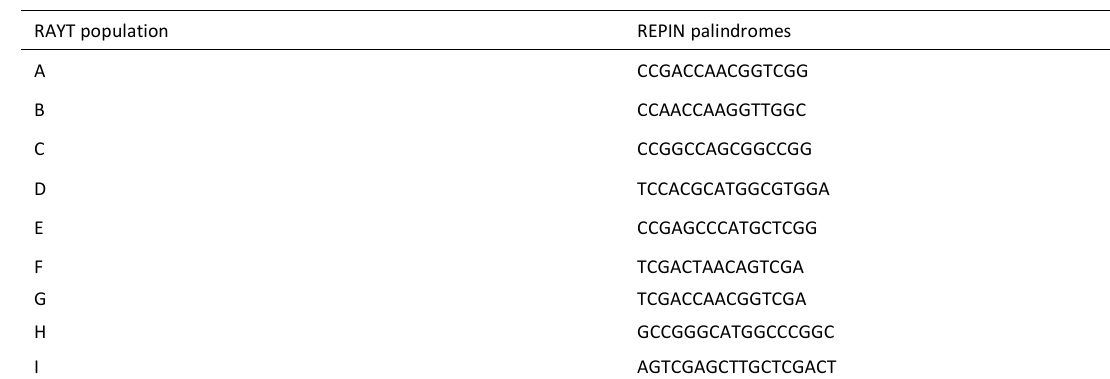
Table 2 - REPIN palindromes associated with each RAYT